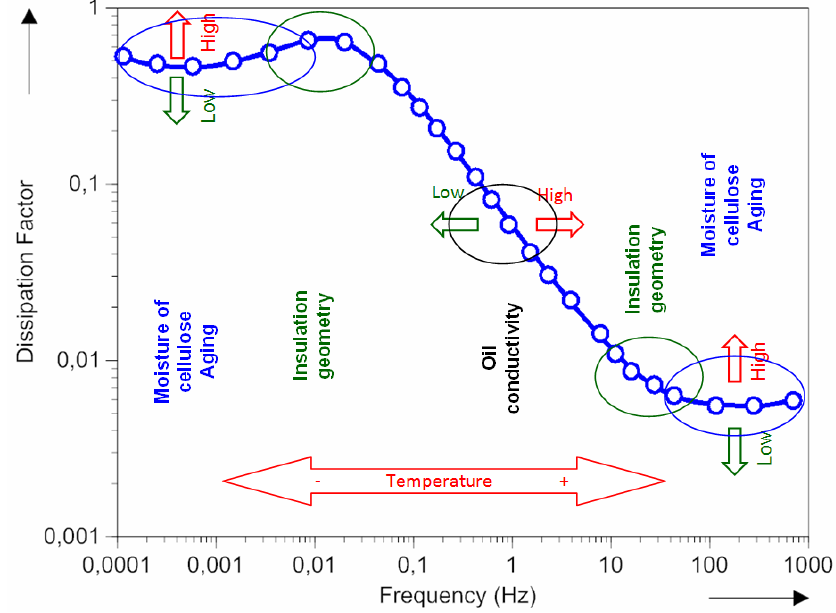
Figure 5. Separate impacts of oil conductivity and moisture in cellulose on frequency domain spectroscopy (FDS).